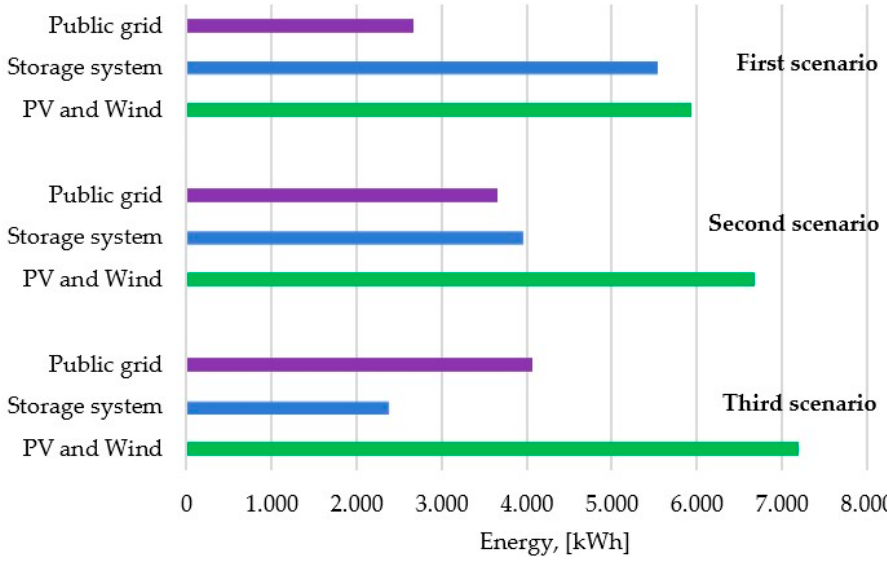
Figure 14. Delivered energy to household consumer by each system type.